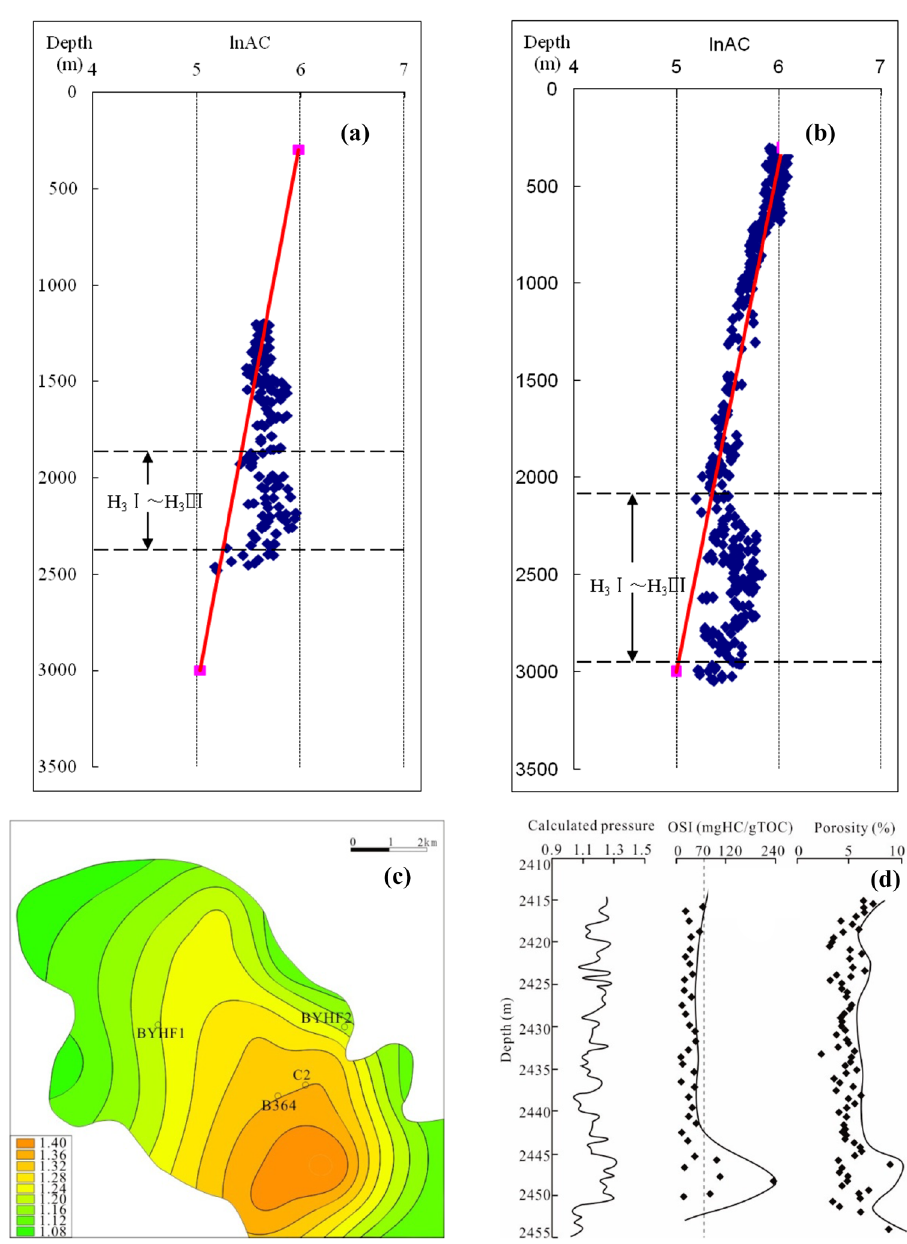
Fig. 6 The relationship between depth and acoustic time data from well BYHF 1 ( a ) and well B364 ( b ); c average forma- tion pressure isoline of ORI 5; d well BYHF 1 correlation between overpressure, OSI and porosity values in ORI